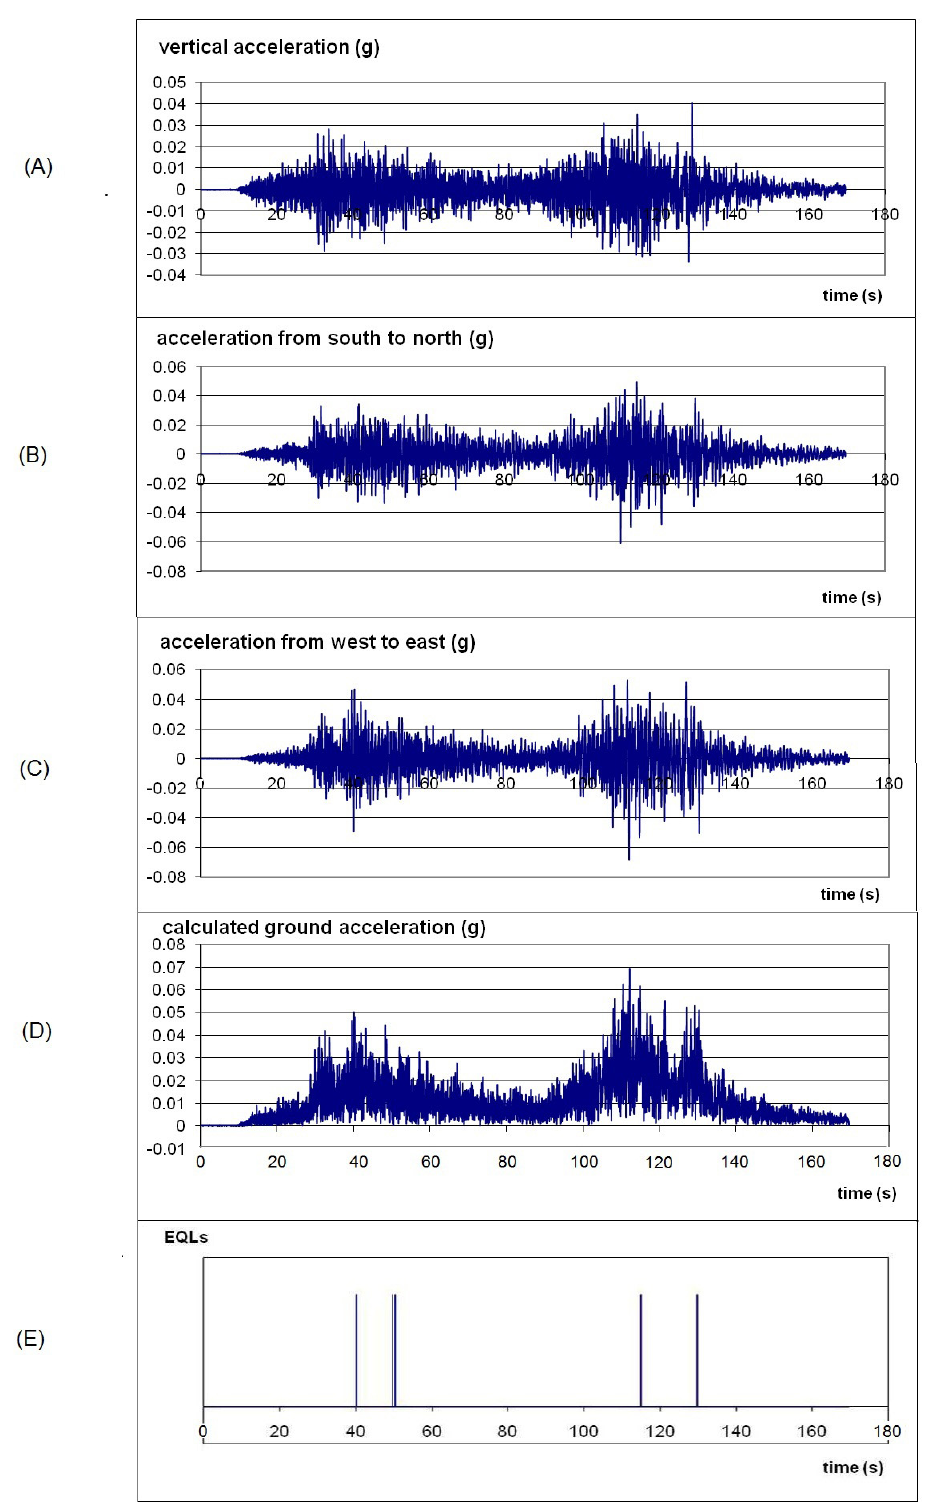
Fig. 10. The acceleration records registered at the PUCP campus ( A , B , and C ), only 500m away from the video camera that registered the EQLs. (D) shows the value of the ground acceleration vector. (E) shows the time difference of the EQLs obtained from the video.